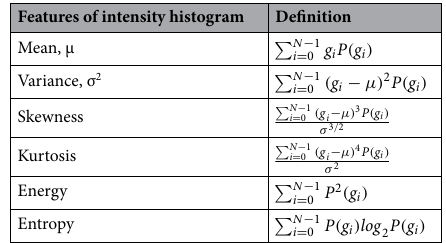
Table 4. Discrete probabilities p ( g i ) of gray levels g i , with i = 0, . . . . . . N − 1 ( L = 8192 ) , in a standardised